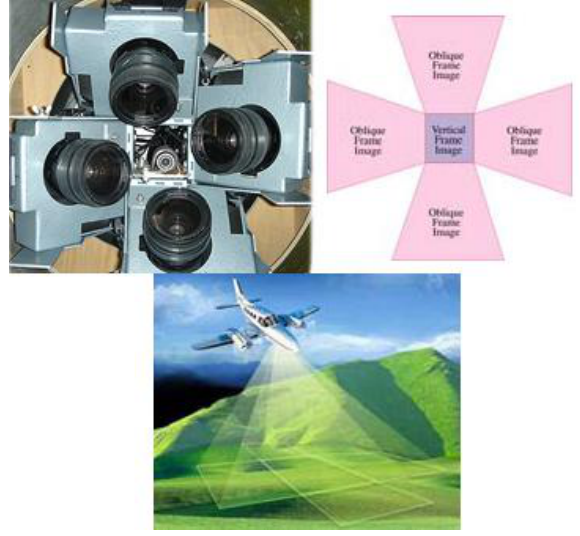
Figure 3. Five camera system (Petrie,